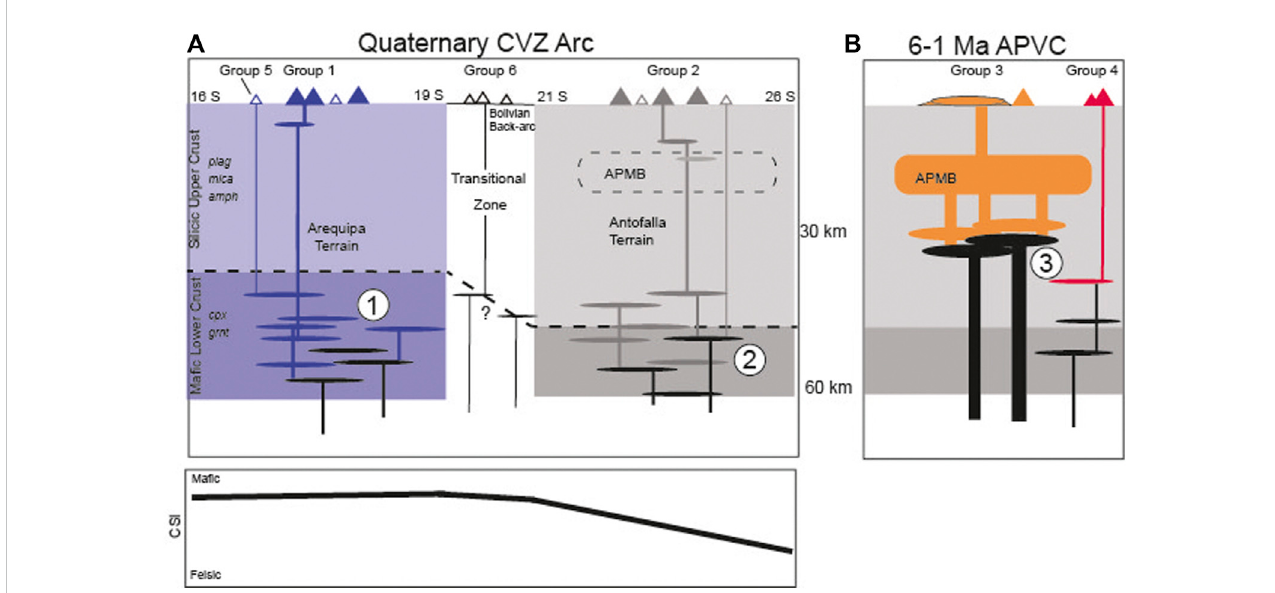
FIGURE 5 Schematic diagrams illustrating the different mechanisms for andesite formation in the CVZ. (A) includes Quaternary andesites from the frontal arc. Diagrams highlight difference in the composition of the crust. Crust between 16 and 19 ° S contains a signi fi cantly higher proportion of ma fi c crust than the crust between 21 and 26 ° S. CSI (Crustal Structure Index) is a measure of the proportion of ma fi c to felsic crust in the basement beneath the CVZ (based on gravity modeling) and is discussed in detail by Mamani et al. (2008). The APMB is the geophysically imaged Altiplano-Puna Magma Body proposed to reside in the upper crust between 21 and 24 ° S (e.g.; Chmielowski et al., 1999; Ward et al., 2017). (B) includes andesites associated with the peak and waning stagesoftheregionalignimbrite fl are-up.Thenumbersincludedinbothpanelsshowslocation(s)ofproposedandesitegenerationinthecrust.Seethetextfor